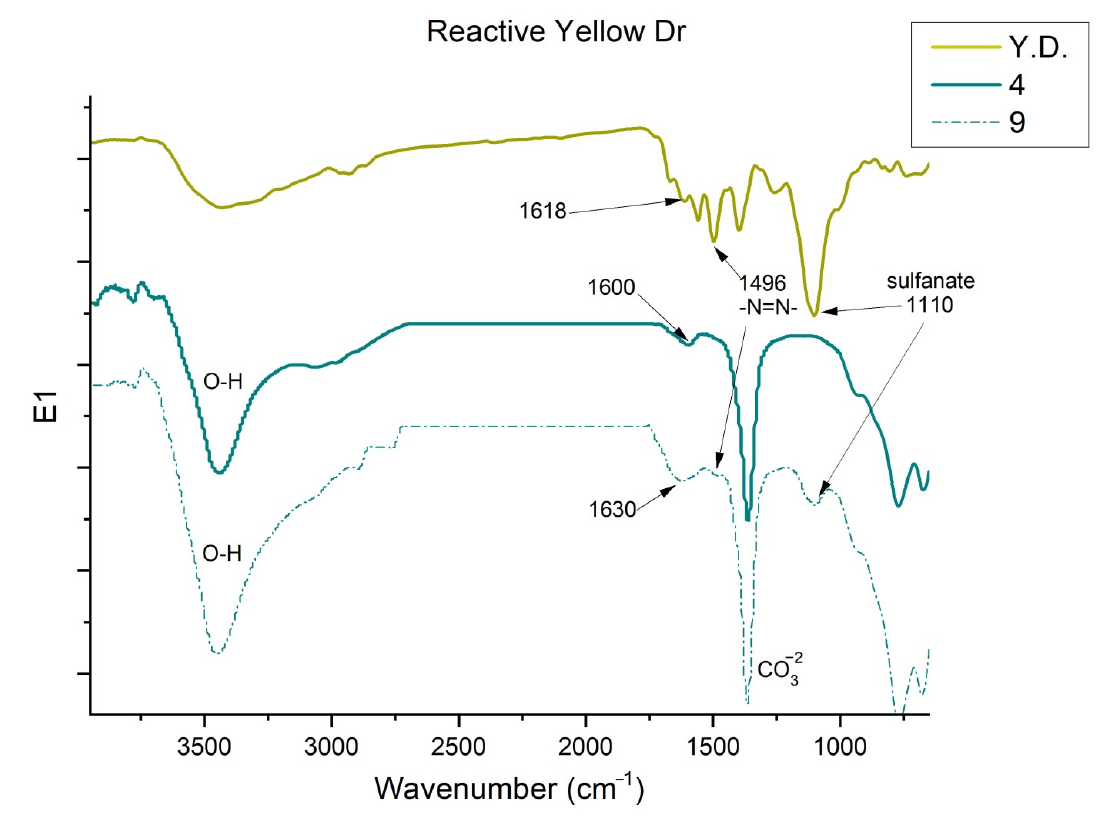
Figure 16. FTIR of Yellow DR, Sample 4 and Sample 9.